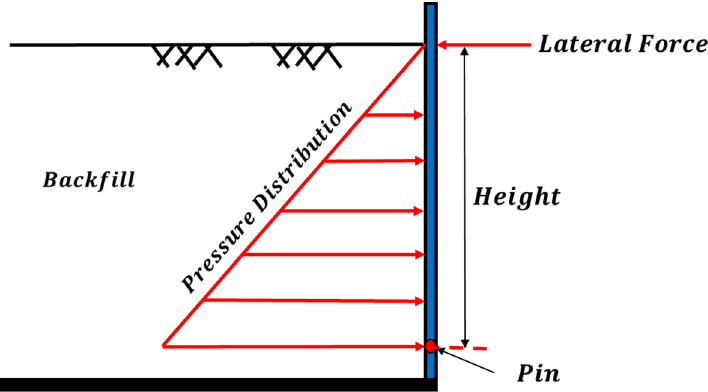
Figure 9. Assumed distribution of the soil pressure required to equilibrate the force P applied on the top.